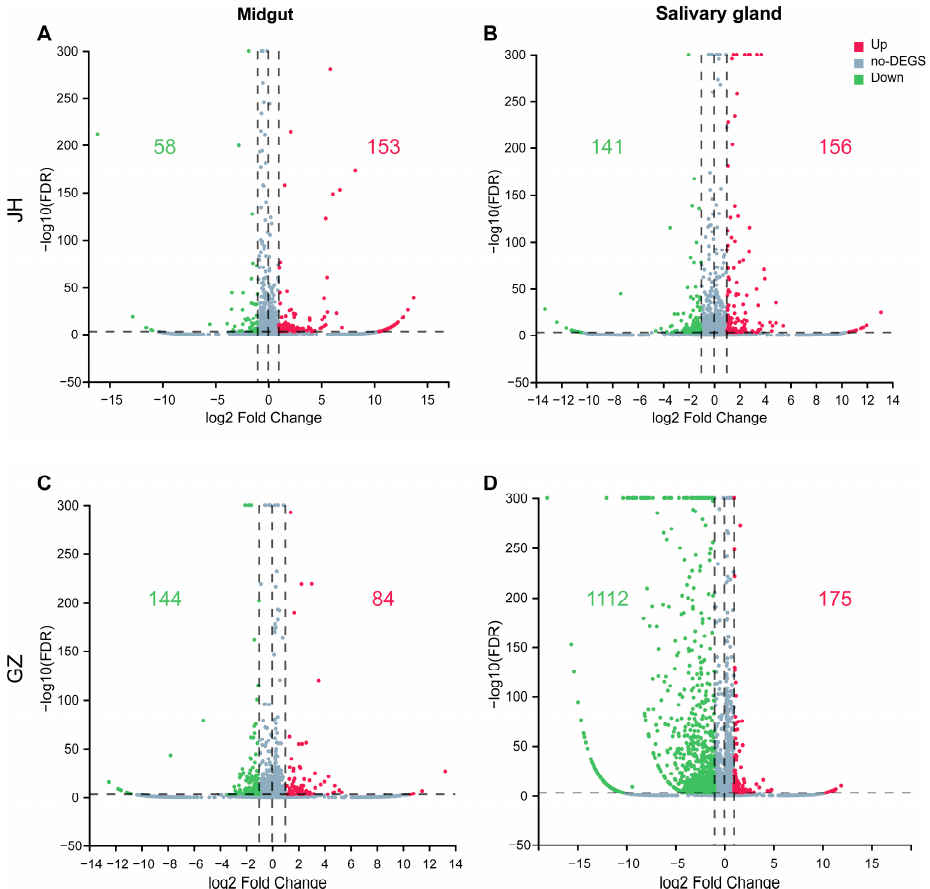
Figure 2. Volcano plot of DEGs (|log2FC| > 1, FDR < 0.001). mRNA expression levels in the midgut ( A , C ) and salivary gland ( B , D ) of Ae. albopictus JH and GZ strains infected with ZIKV were compared to those of the non-infected. Red and green plots indicate significantly upregulated and downregulated genes, respectively. Light blue plots indicate genes that were not significantly different between the infected and non-infected groups. Number of up- or downregulated genes was shown in the relative quadrant with the same color.